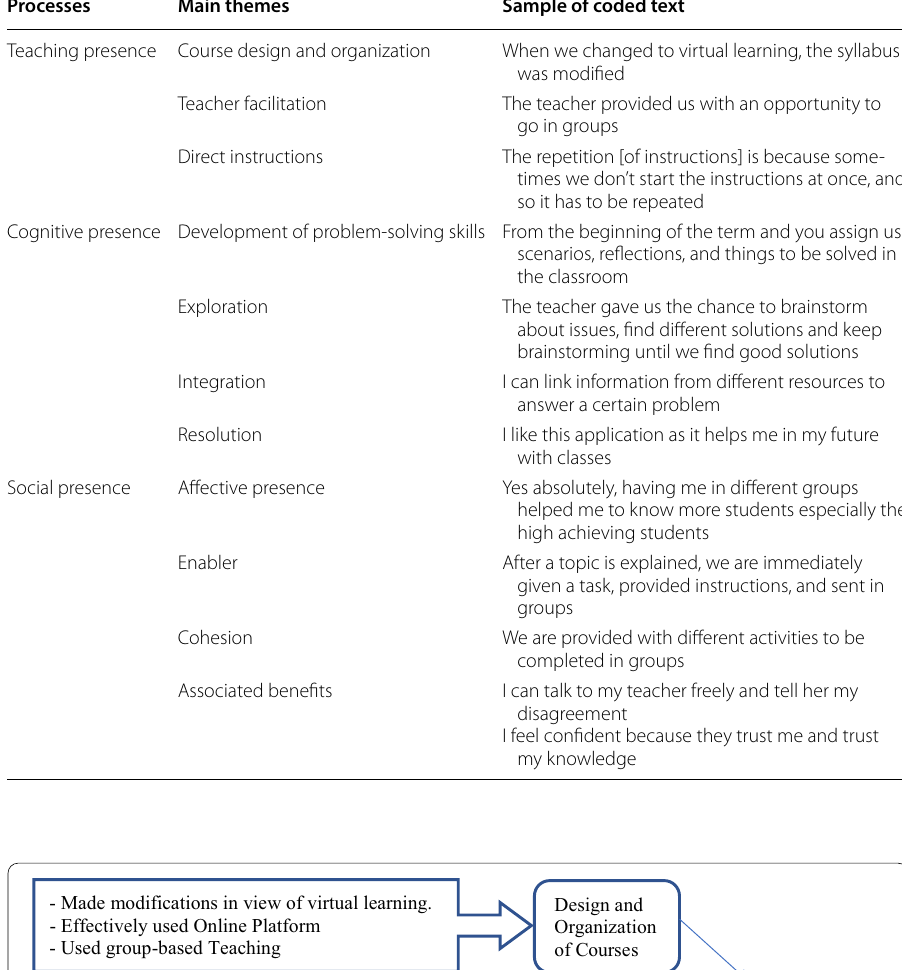
Table 1 Themes and Sub-themes of Emirati female college students’ experiences Processes